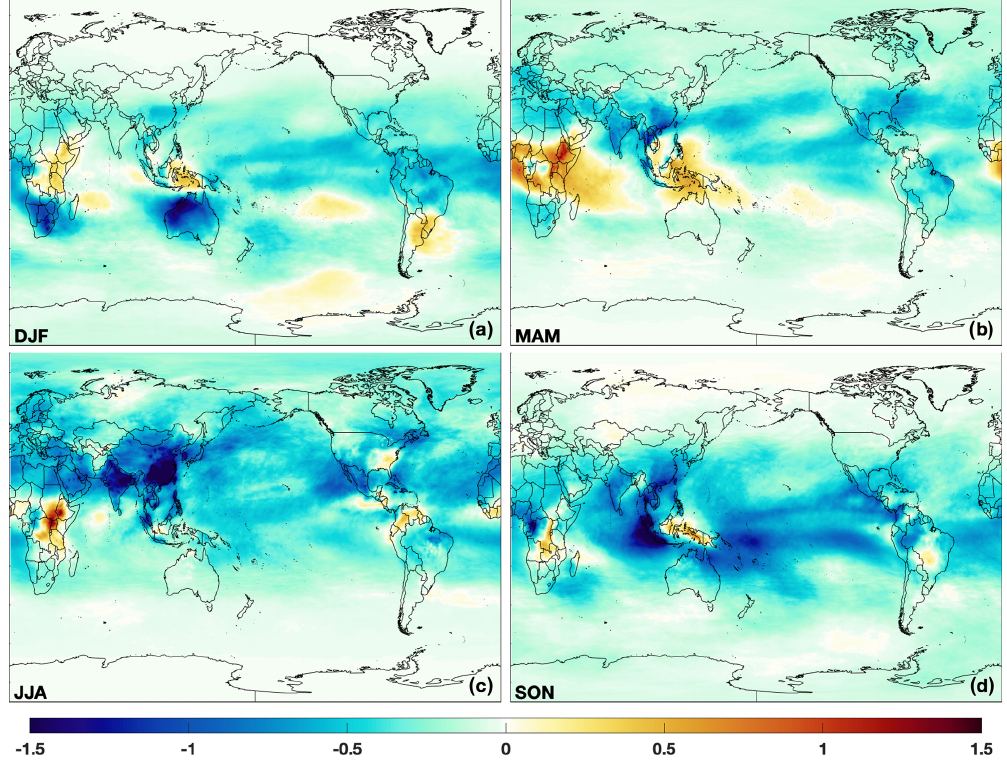
Figure 8. The first EOF of TCOH from MERRA-2 GMI for DJF (a) , MAM (b) , JJA (c) , and SON (d) .